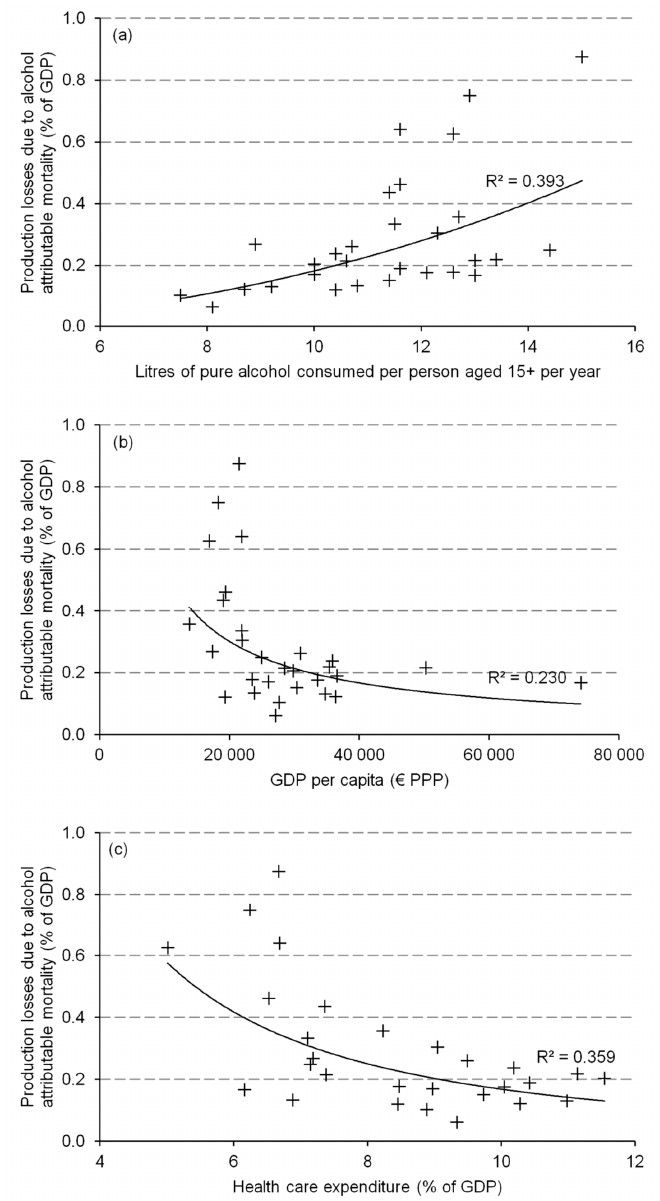
Figure 3. Association between production losses due to alcohol-attributable mortality and ( a ) consumption of pure alcohol per person aged 15+ per year (litres); ( b ) GDP per capita (€ PPP); and ( c ) health care expenditure as a share of GDP. Notes: GDP—gross domestic product; PPP—purchasing power parity. Source: own